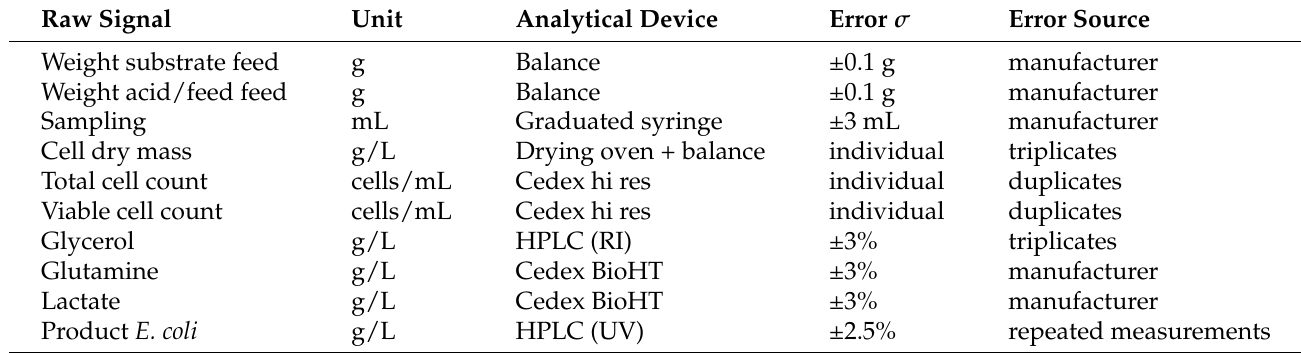
Table 1. Uncertainties of the